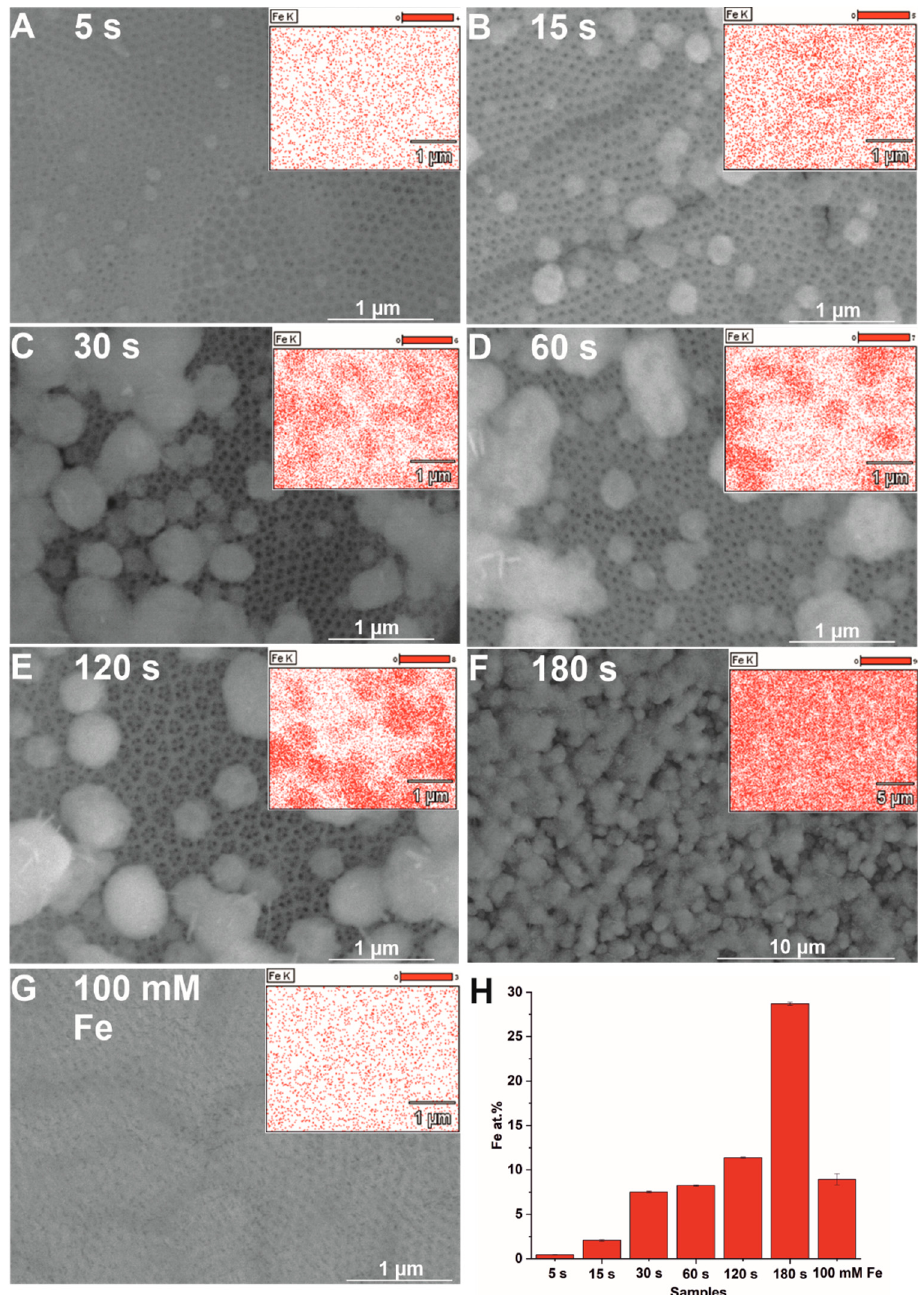
Figure 2. SEM images with EDS maps of Fe distribution (insets) of hybrid Fe 2 O 3 –TiO 2 samples electrodeposited for 5 s ( A ), 15 s ( B ), 30 s ( C ), 60 s ( D ), 120 s ( E ), and 180 s ( F ), and impregnated in a 100 mM FeCl 3 solution ( G ). The estimated average iron content for the corresponding modified samples ( H ).